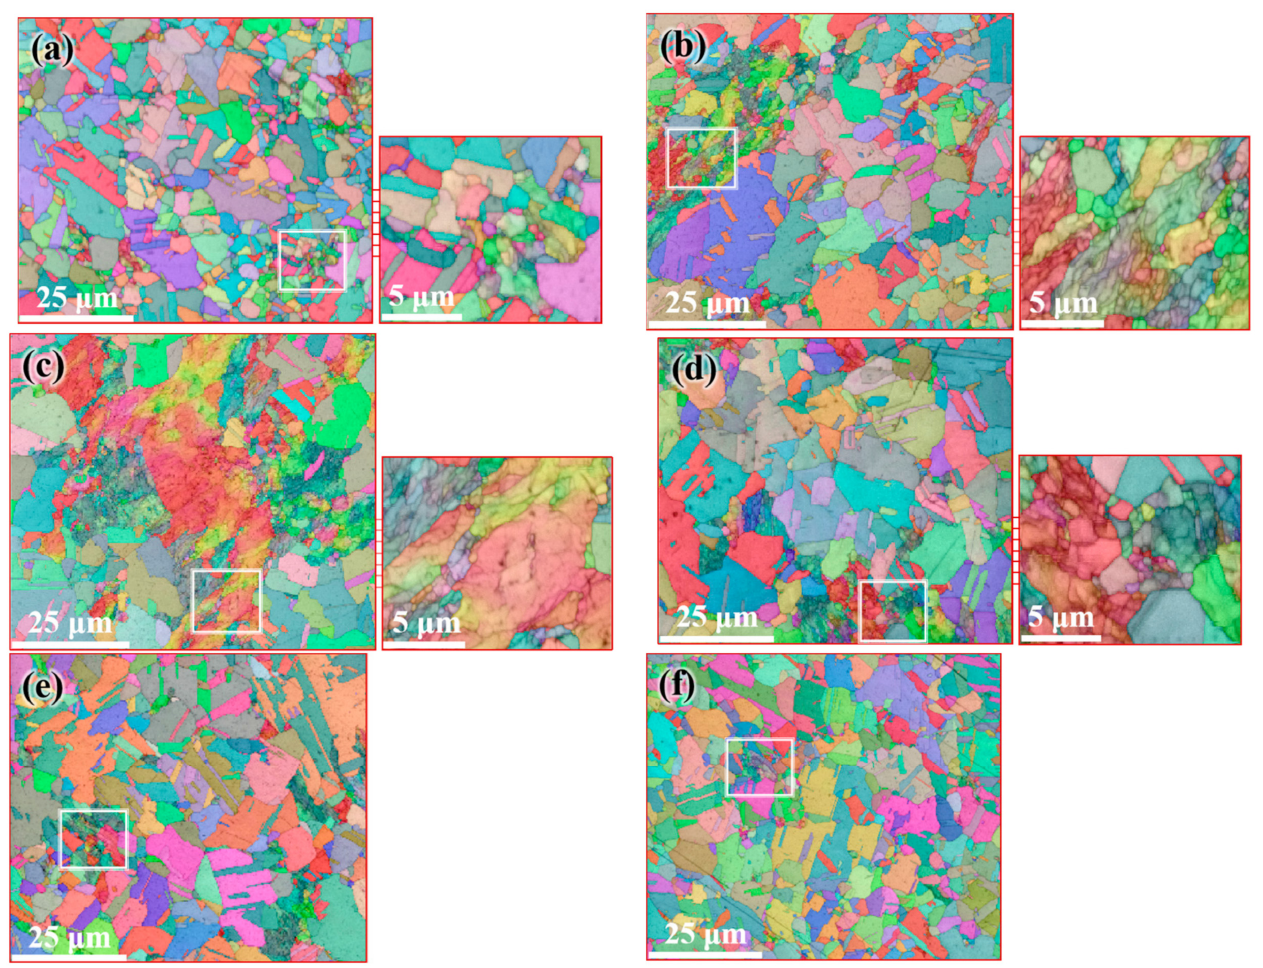
Figure 9. Distribution of microstructure after FCE at 150 ◦ C: ( a ) 250 µ m from the edge, ( b ) 1 mm from the edge, ( c ) 2 mm from the edge, ( d ) 4 mm from the edge, and ( e , f ) 250 µ m from the edge.